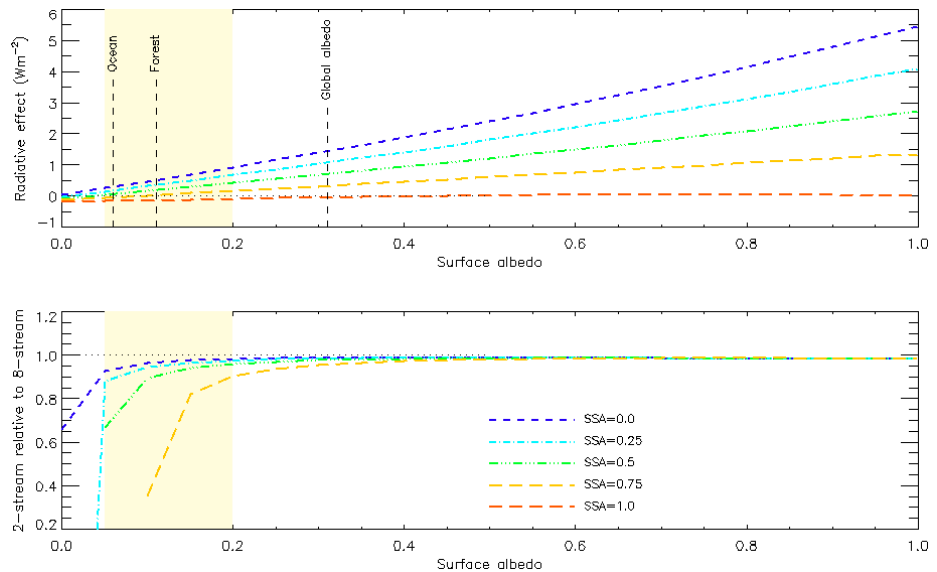
Figure 3. RF as a function of surface albedo for various single scattering albedo (upper), and relative differences between two-stream and multi-stream simulations (lower). In cases where the sign of two-stream and multi-stream simulations for a particular single-scattering albedo differs the results are left out of the lower